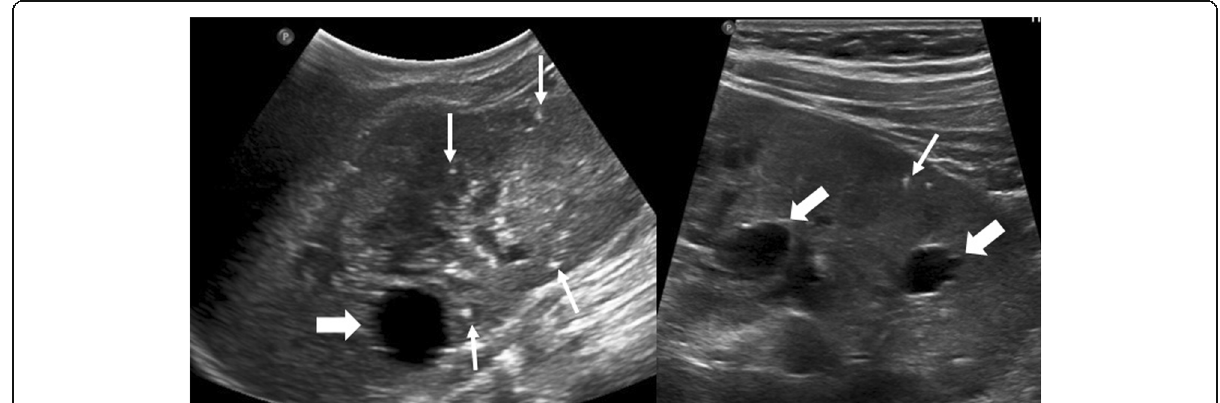
Fig. 22 A 9-year-old male patient with known TSC underwent follow-up US exam. US images show punctate hyperechoic foci consistent with